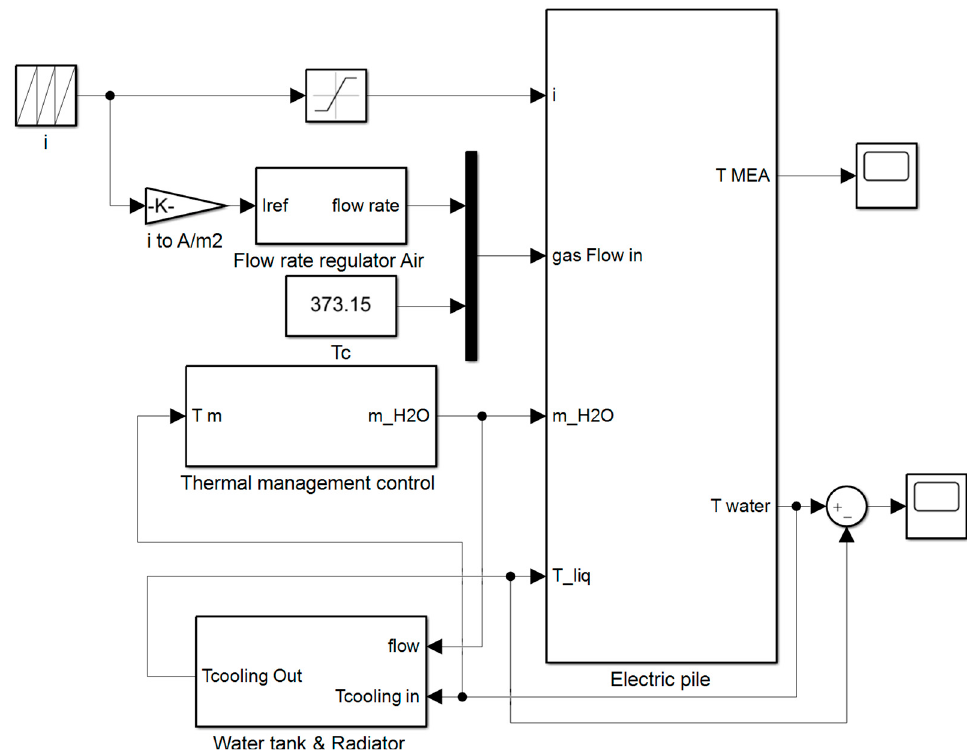
Figure 10. Thermal management system model.